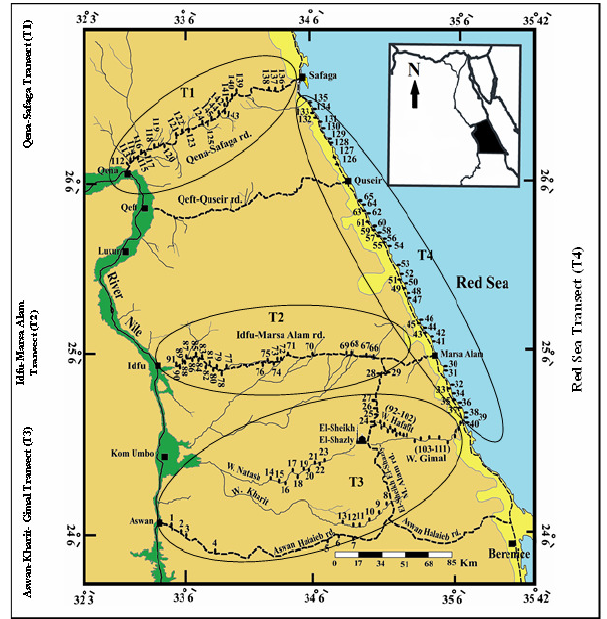
Fig. 1. Location map of the study area, showing the distribution of the studied stands along the 4